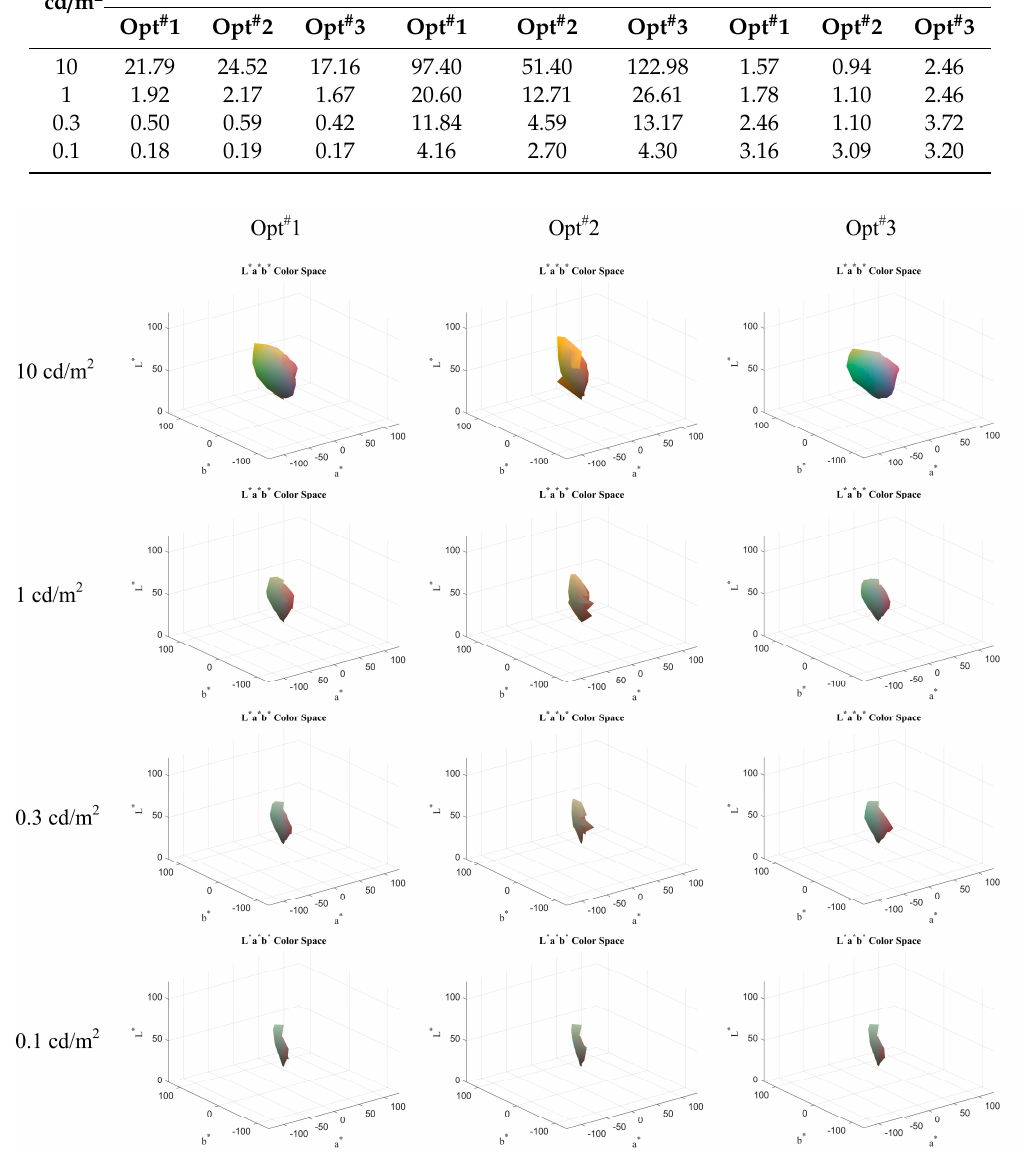
Figure 3. Illustration of color gamut of optimal SPDs.